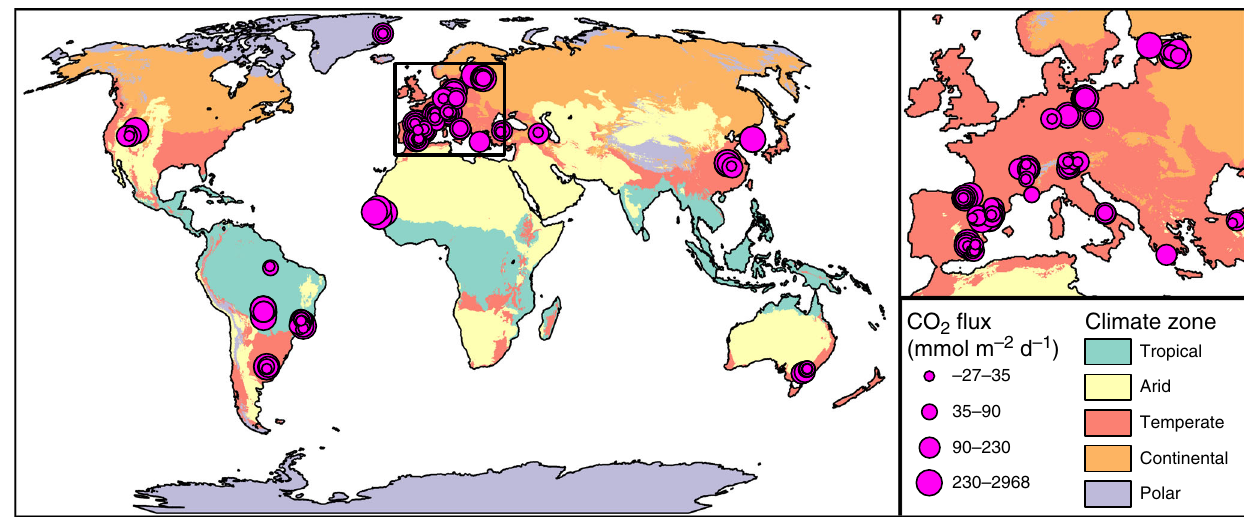
Fig. 1 Global distribution of CO 2 fl uxes from dry inland waters. Size of pink dots indicates magnitude of measured CO 2 fl uxes. Background colours indicate climate zones according to the Köppen – Geiger climate classi fi cation system 52 . Inset illustrates the spatial distribution within the most densely sampled